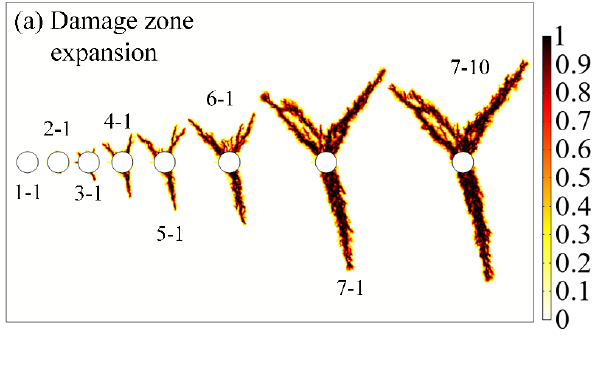
Figure 7. Damage zone expansion, crack expansion, pore pressure distribution and elastic modulus degradation law around hydraulic fracturing drilling when ξ = 0.5. (Note that: the color bar in Figure 7 ( a ) represents the damage variable, D ; the color bar in Figure 7 ( b ) represents the crack expansion, ( c ) represents the pore pressure value; the color bar in Figure 7 ( d ) represents the elastic modulus value at different areas).